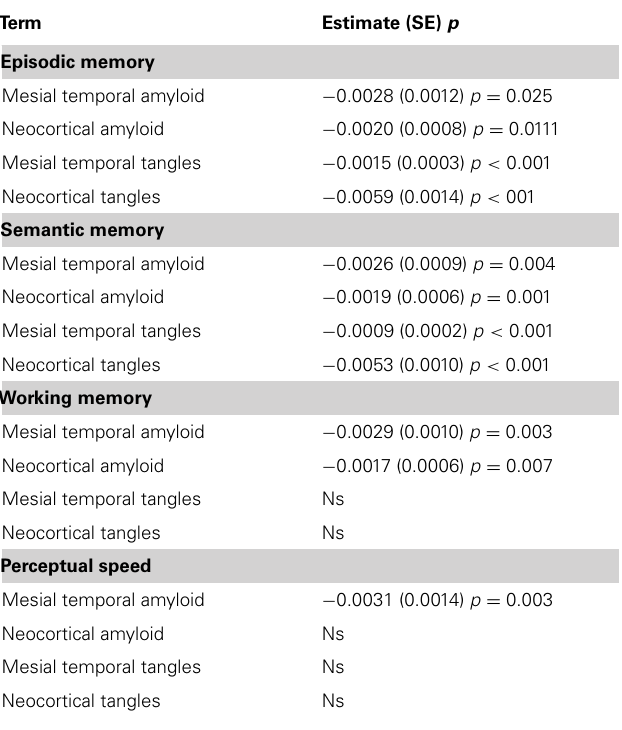
Table 3 | Relation of the regionally specific neuropathology with rate of decline in four cognitive